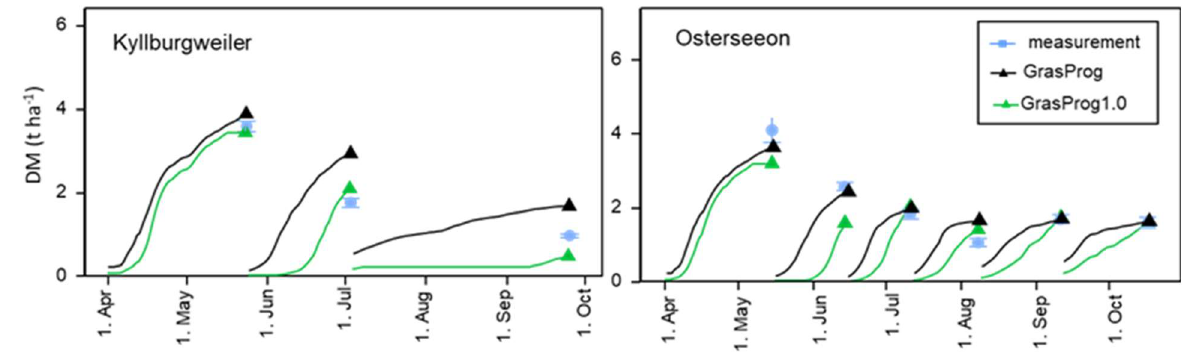
Figure 4. GrasProg1.0 predictions of the grass growth (dry matter; DM) in 2018 for Kyllburgweiler and Osterseeon, either without (black lines) or with the legacy (green lines)